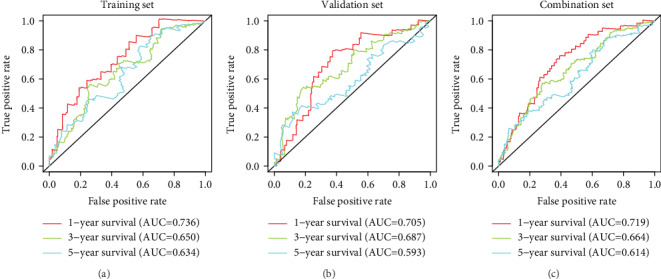
ROC curves of 1-, 3-, and 5-year overall survivals of the risk signature in three sets. (a) Training set. (b) Validation set. (c) Combination set. ROC: receiver operating characteristic.